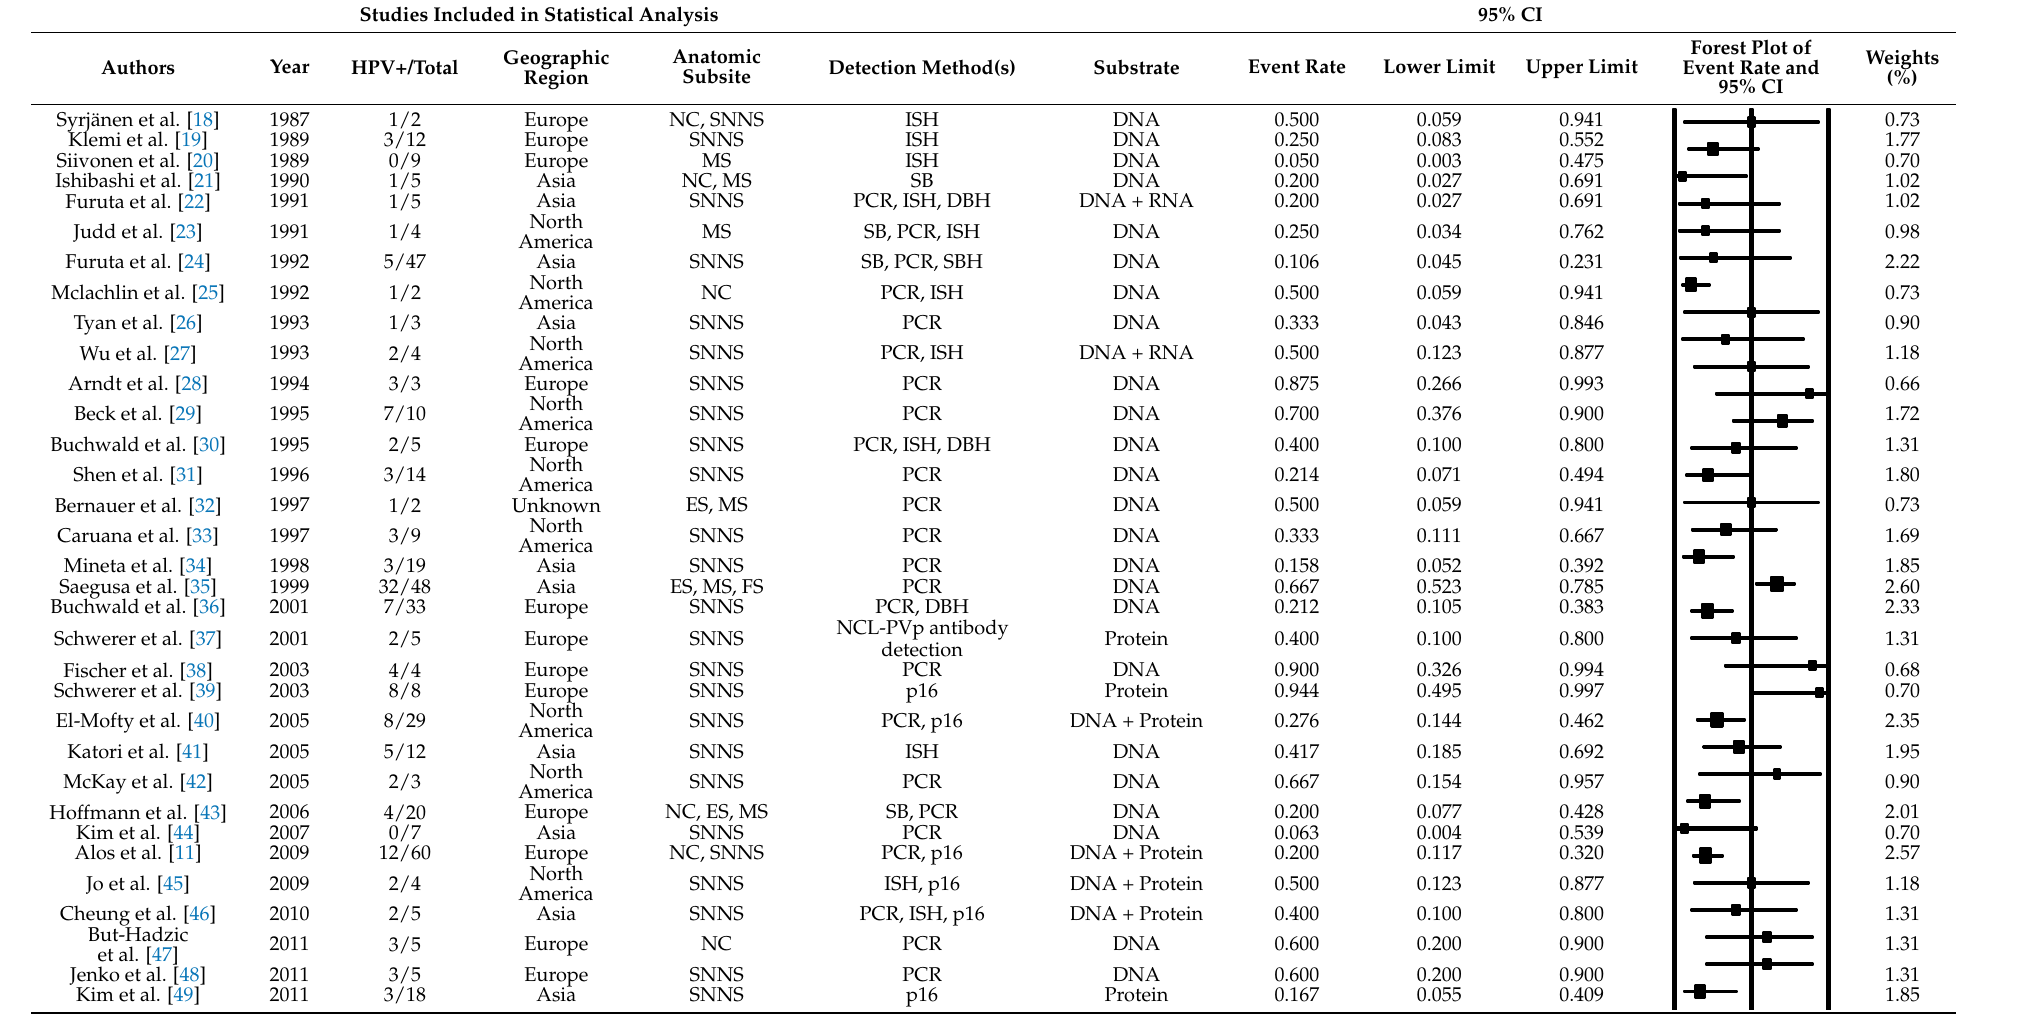
Table 1. Overview of study characteristics. Table showing all 60 studies eligible for the statistical analysis including study characteristics, human papillomavirus (HPV) prevalence estimates using the random-effects model, and forest plot. Study characteristics of the nine excluded studies are shown in grey.